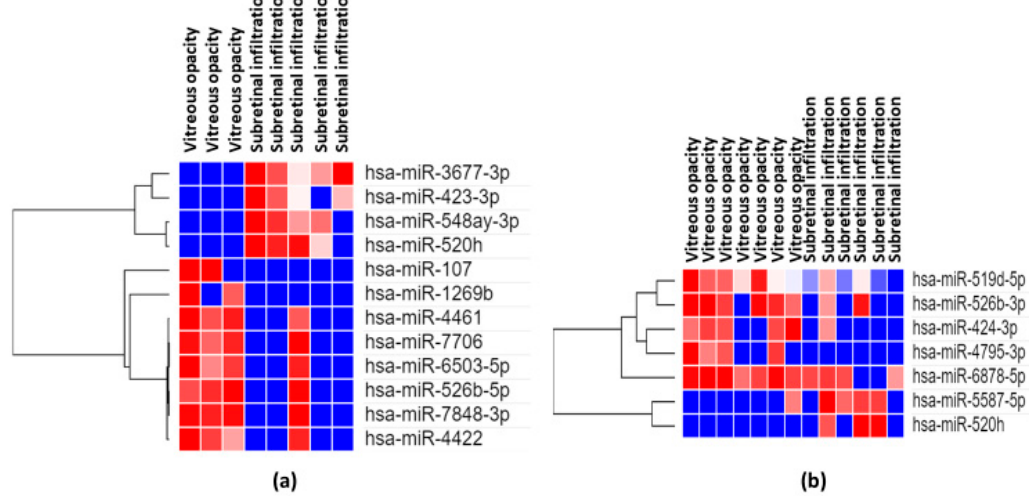
VRL patients were divided into two groups according to clinical features: di ff use vitreous opacities Figure 10. Correlation diagram between IL-10 and miR-1236-3p. There is a positive correlation with or without multiple subretinal white lesions. We evaluated the association between vitreous miRNA expression and clinical features (Figure 11). between the relative expression levels of IL-10 and miR-1236-3p in the vitreous of VRL patients ( r = 0.952, p < 0.05).